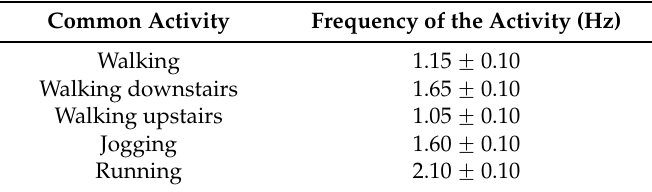
Table 3. Summary of the common activities and their frequencies.